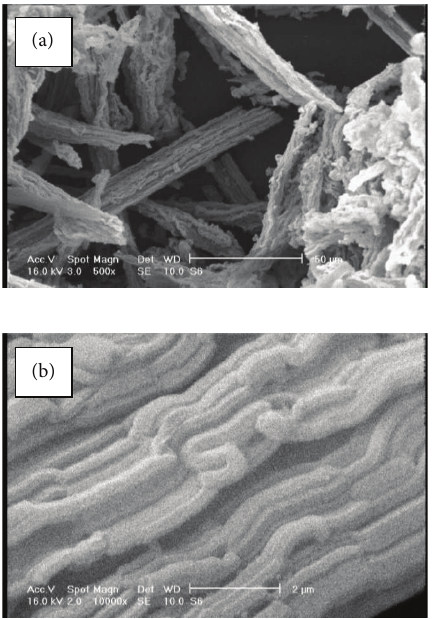
Figure 5: SEM microphotographs of SBA-3 (a) 50 𝜇 m and (b) 2 𝜇 m.